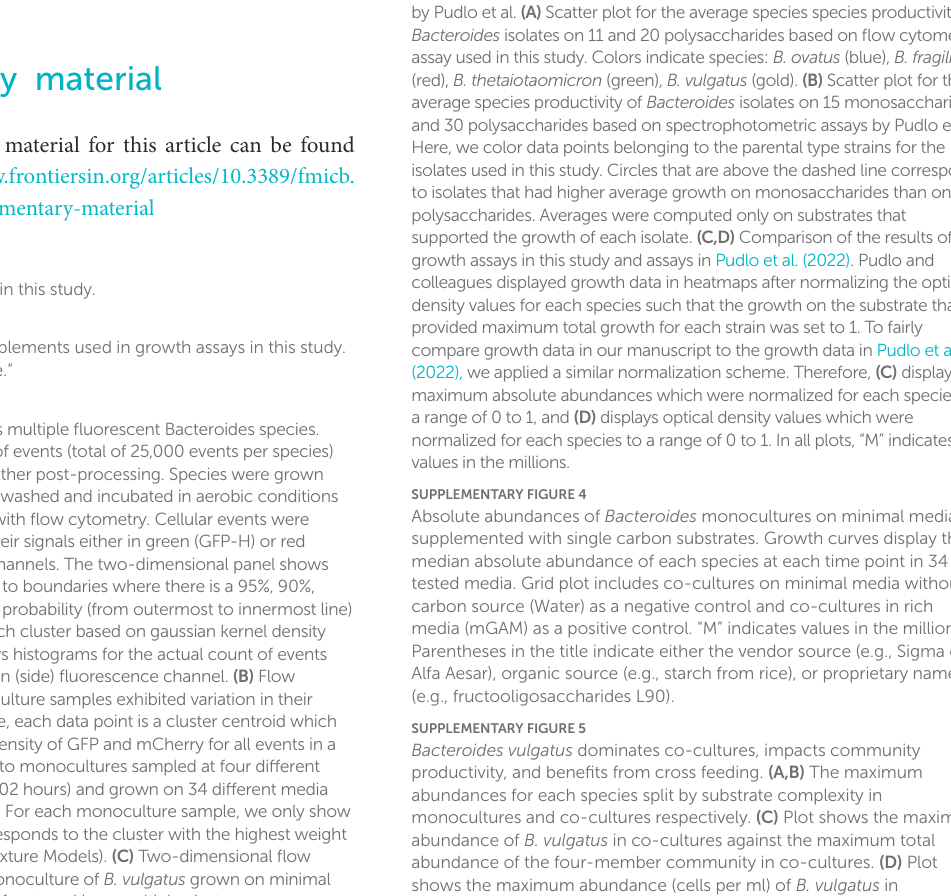
SUPPLEMENTARY FIGURE 3 Comparison of monoculture assays between flow cytometry-based measurements in this work and spectrophotometry-based measurements by Pudlo et al. (A) Scatter plot for the average species productivity of Bacteroides isolates on 11 and 20 polysaccharides based on flow cytometric assay used in this study. Colors indicate species: B. ovatus (blue), B. fragilis (red), B. thetaiotaomicron (green), B. vulgatus (gold). (B) Scatter plot for the average species productivity of Bacteroides isolates on 15 monosaccharides and 30 polysaccharides based on spectrophotometric assays by Pudlo et al. Here, we color data points belonging to the parental type strains for the isolates used in this study. Circles that are above the dashed line correspond to isolates that had higher average growth on monosaccharides than on polysaccharides. Averages were computed only on substrates that supported the growth of each isolate. (C,D) Comparison of the results of the growth assays in this study and assays in Pudlo et al. (2022). Pudlo and colleagues displayed growth data in heatmaps after normalizing the optical density values for each species such that the growth on the substrate that provided maximum total growth for each strain was set to 1. To fairly compare growth data in our manuscript to the growth data in Pudlo et al. (2022), we applied a similar normalization scheme. Therefore, (C) displays maximum absolute abundances which were normalized for each species to a range of 0 to 1, and (D) displays optical density values which were normalized for each species to a range of 0 to 1. In all plots, “M” indicates values in the millions. SUPPLEMENTARY FIGURE 4 Absolute abundances of Bacteroides monocultures on minimal media supplemented with single carbon substrates. Growth curves display the median absolute abundance of each species at each time point in 34 tested media. Grid plot includes co-cultures on minimal media without a carbon source (Water) as a negative control and co-cultures in rich media (mGAM) as a positive control. “M” indicates values in the millions. Parentheses in the title indicate either the vendor source (e.g., Sigma or Alfa Aesar), organic source (e.g., starch from rice), or proprietary name (e.g., fructooligosaccharides L90). SUPPLEMENTARY FIGURE 5 Bacteroides vulgatus dominates co-cultures, impacts community productivity, and benefits from cross feeding. (A,B) The maximum abundances for each species split by substrate complexity in monocultures and co-cultures respectively. (C) Plot shows the maximum abundance of B. vulgatus in co-cultures against the maximum total abundance of the four-member community in co-cultures. (D) Plot shows the maximum abundance (cells per ml) of B. vulgatus in monocultures against the relative change in productivity, defined as the ratio of “maximum co-culture productivity” to “maximum monoculture productivity,” for each substrate. (E) . Plot shows the